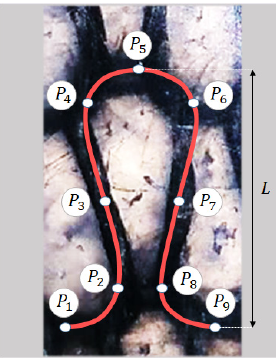
Figure 2. Schematic illustration of the fiber tow centerline curve of a loop of the manufactured knitted carbon fiber/PP composite, and the corresponding points ( P 1 – P 9 ) used to define the B-spline curve.